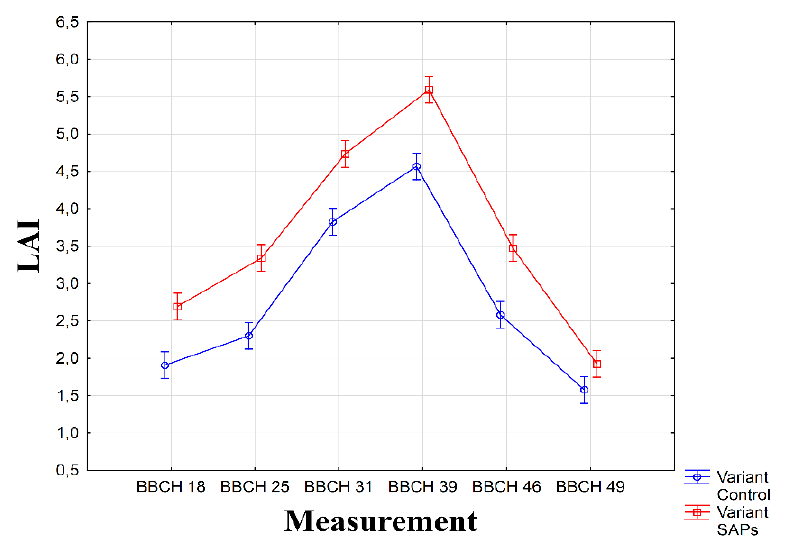
Figure 2. Interaction between experimental treatments and measurements for leaf area index (LAI). Figure was obtained at level of significance α = 0.01. Table 1. Analysis of variance (ANOVA) for impact of different source of variation on production parameters: root yield (RY), sugar content (SC), white sugar yield (WSY) and physiological param- eters: leaf area index (LAI), photochemical reflectance index (PRI).